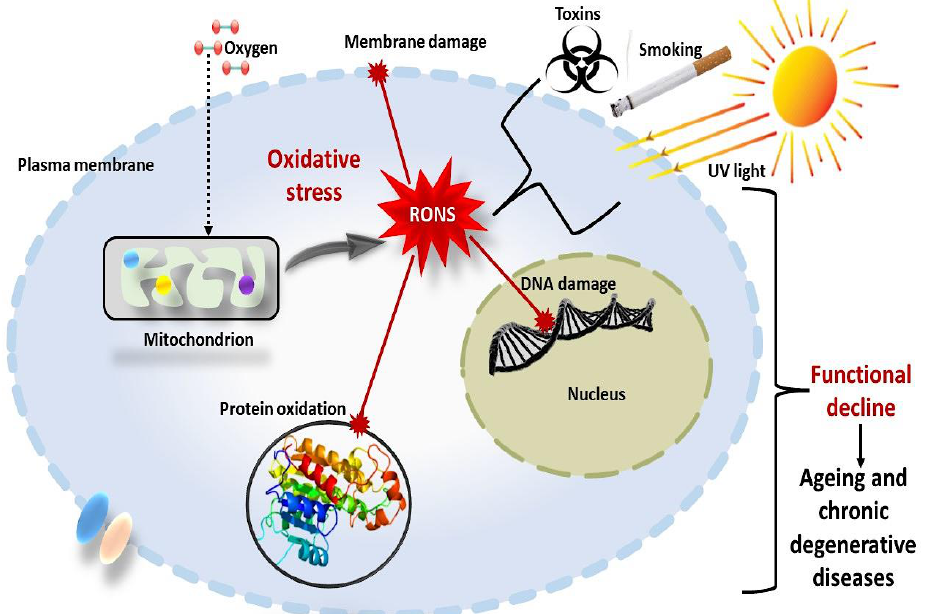
Figure 1. Schematic representation of oxidative stress, a phenomenon elevated with ageing and degenerative diseases. It involves the accumulation of reactive oxygen and nitrogen species (RONS) in cells and tissues, harmfully modifying deoxyribonucleic acid (DNA), proteins and lipids and triggering ageing and chronic degenerative diseases.